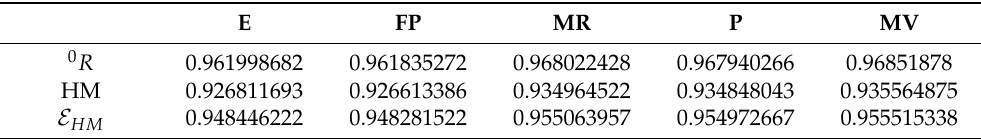
Table 2. Correlation of 0 R , HM and E HM with the physicochemical properties of potential drugs which can be used as treatment of COVID-19. E